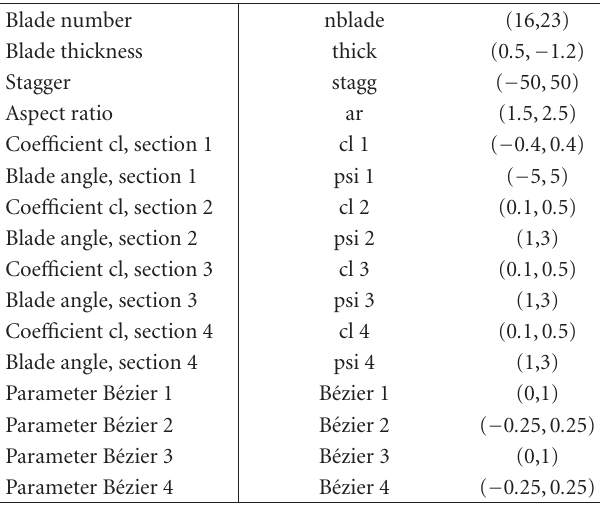
Table 3: Sixteen initial variables and their range of